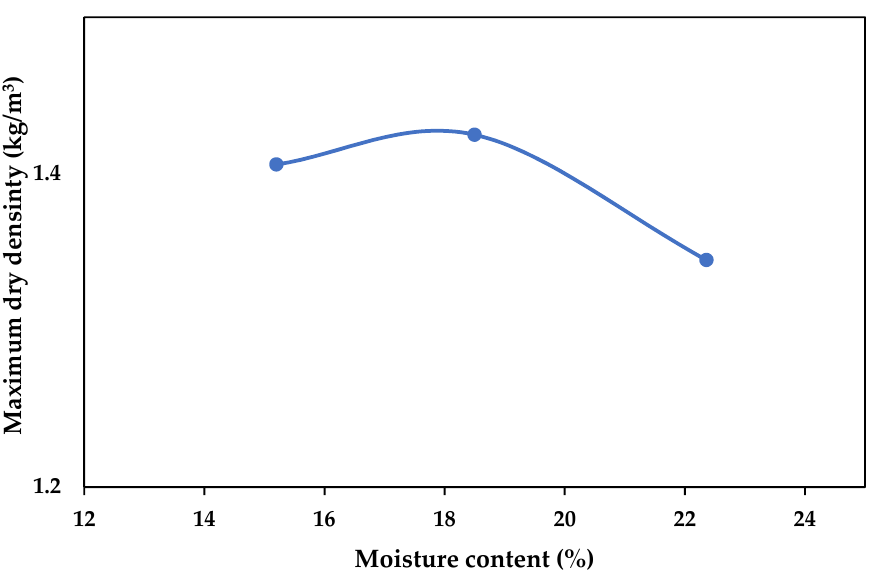
Figure 6. MDD and OMC of WFGD gypsum.